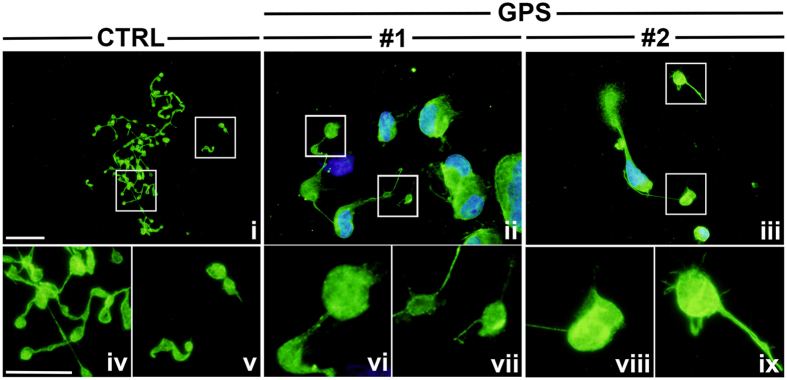
Giant proplatelet tips and released platelets from GPS megakaryocytes.Panel shows terminal proplatelet formation and platelet release by healthy controls (CTRL) (i) and GPS (ii,iii) megakaryocytes in vitro (green = α-tubulin; blue = nuclei; scale bar = 40 μm). Boxes highlight terminal proplatelet tips and platelet released in culture. Noteworthy, the size of both platelets tips and released platelets is markedly increased in GPS (vi,vii and viii,ix) than in CTRL (iv,v) samples (green = α-tubulin; scale bar = 20 μm).